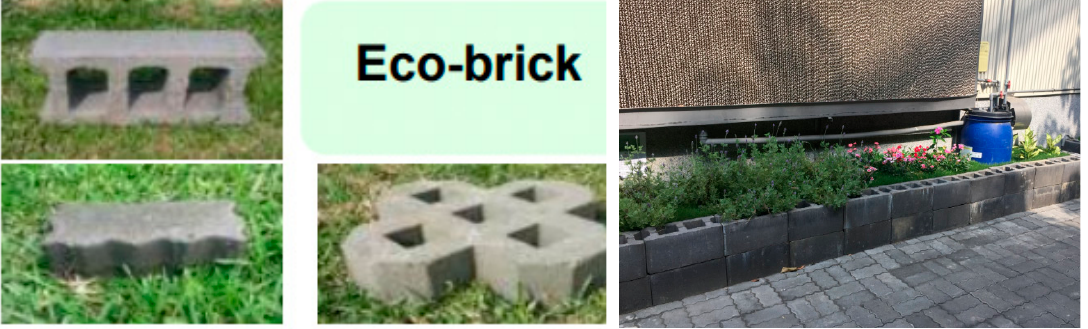
Figure 8. Eco-brick made from waste cinder and used in the factory.